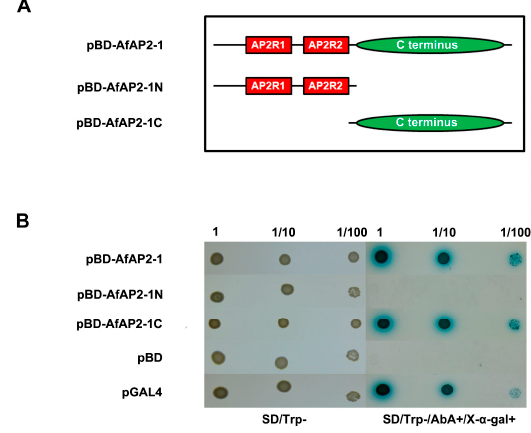
Figure 4. Transactivation activity assay of AfAP2-1 in yeast cells. ( A ) Schematics of the constructs of pGBKT7 (pBD) vectors fused with full-length AfAP2-1 (pBD-AfAP2-1), the N terminus of AfAP2-1 (pBD-AfAP2-1N) and the C terminus of AfAP2-1 (pBD-AfAP2-1C); ( B ) Transactivation activity assay in yeast cells. pBD and pGAL4 plasmids were transformed into Y2HGold cells and used as negative and positive controls, respectively. Yeast clones containing the right constructs grew on SD/Trp- medium at dilutions of 1, 1/10 and 1/100. Three to five days later, the right clones were transferred onto SD/Trp-/AbA+/X- α -gal+ medium for continuous growth for three days to test their transactivation activities. SD: synthetic dropout; AbA: Aureobasidin A; SD/Trp-: SD medium without Trp; SD/Trp-/AbA+/X- α -gal+: SD medium without Trp, but with 40 mg/L X- α -gal and 200 µg/L AbA.